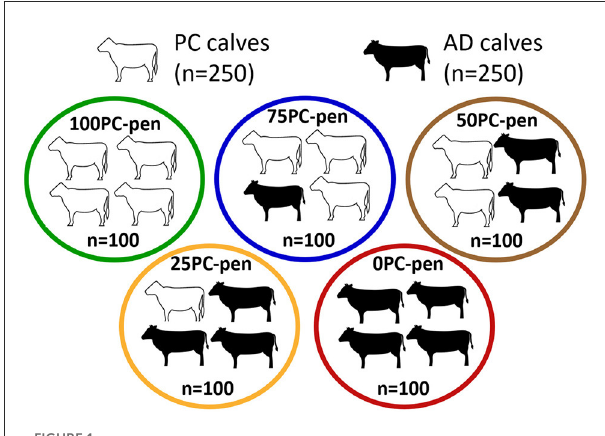
FIGURE1 Schematic representation of calf allocations in each pen. PC, preconditioned calves; AD, auction-derived calves.